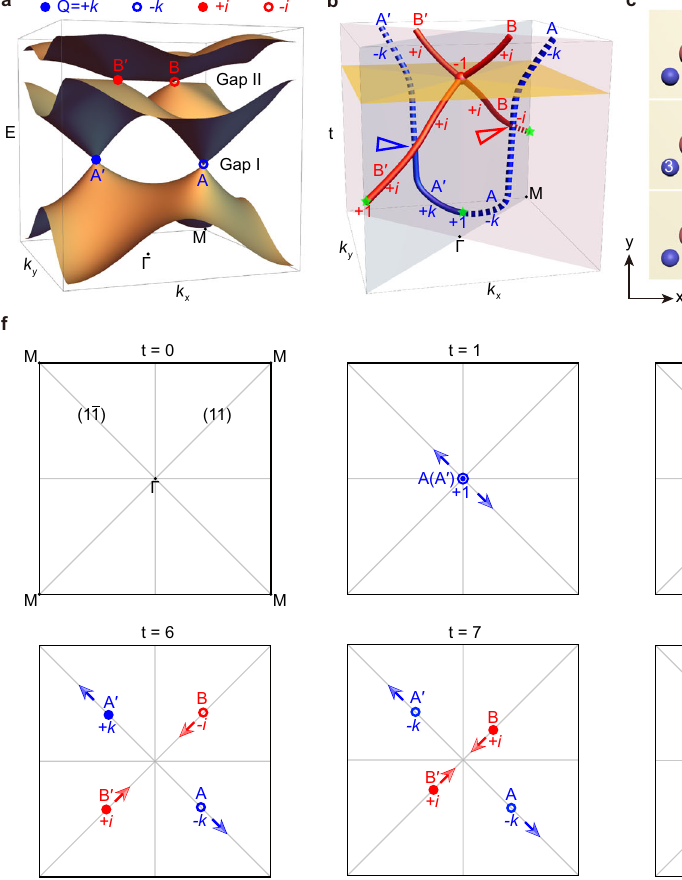
Fig. 1 | Idealnon-abelianbraiding withthefewestnodes.a Schematicofathree- bandsystemwithtwopairsofbandnodesin2Dmomentumspace.Thegap-Inodes A ð A 0 Þ and gap-II nodes B ð B 0 Þ carry non-abelian charges Q = ± k and Q = ± i , respec- tively. b Time evolution of the band nodes (solid and dotted lines), including their creation (at the green stars), braiding (at the colored triangles), collision (in the yellowplane),andrepulsionsuccessively. c Tight-bindingmodel.Thethreeorbitals